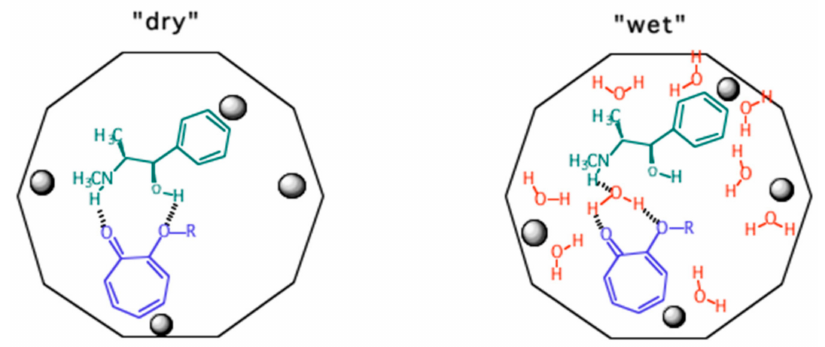
Figure 3. Suggested orientation of the chiral inductor and the reactant within dry and wet zeolites. In dry zeolites, the cation is free, while in wet zeolites, they are surrounded by water molecules